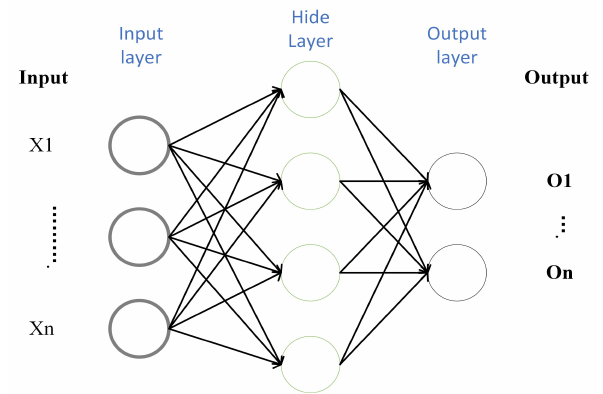
Figure 4. Schematic diagram of full connection layer.